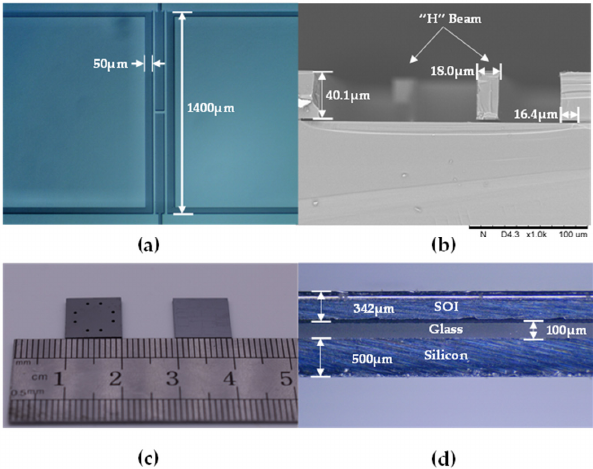
Figure 4. The fabrication results: ( a ) top view of the “H” resonant beam; ( b ) SEM image of the resonant beam; ( c ) front/back views of the microsensor chips and ( d ) side view of the microsensor chip.